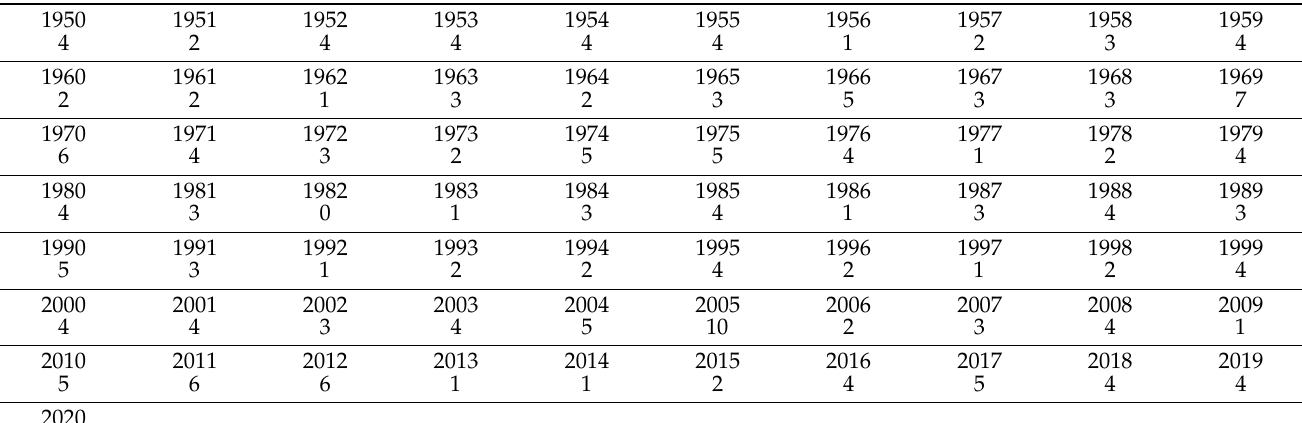
Figure 2. Distributions of STCs with up to four TCs involved. No STC was observed during season in 1982 (labeled in grey inverted triangle). The number of TCs involved in each event is colored. Table 1. Annual number of STCs in the Atlantic